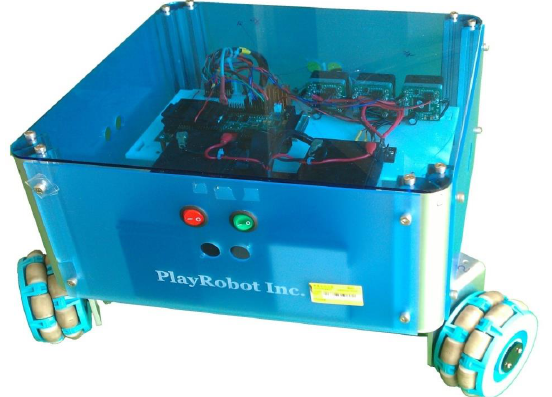
Figure 1. Three dimensional plot of mobile robot Figure 1. Three-dimensional plot of mobile